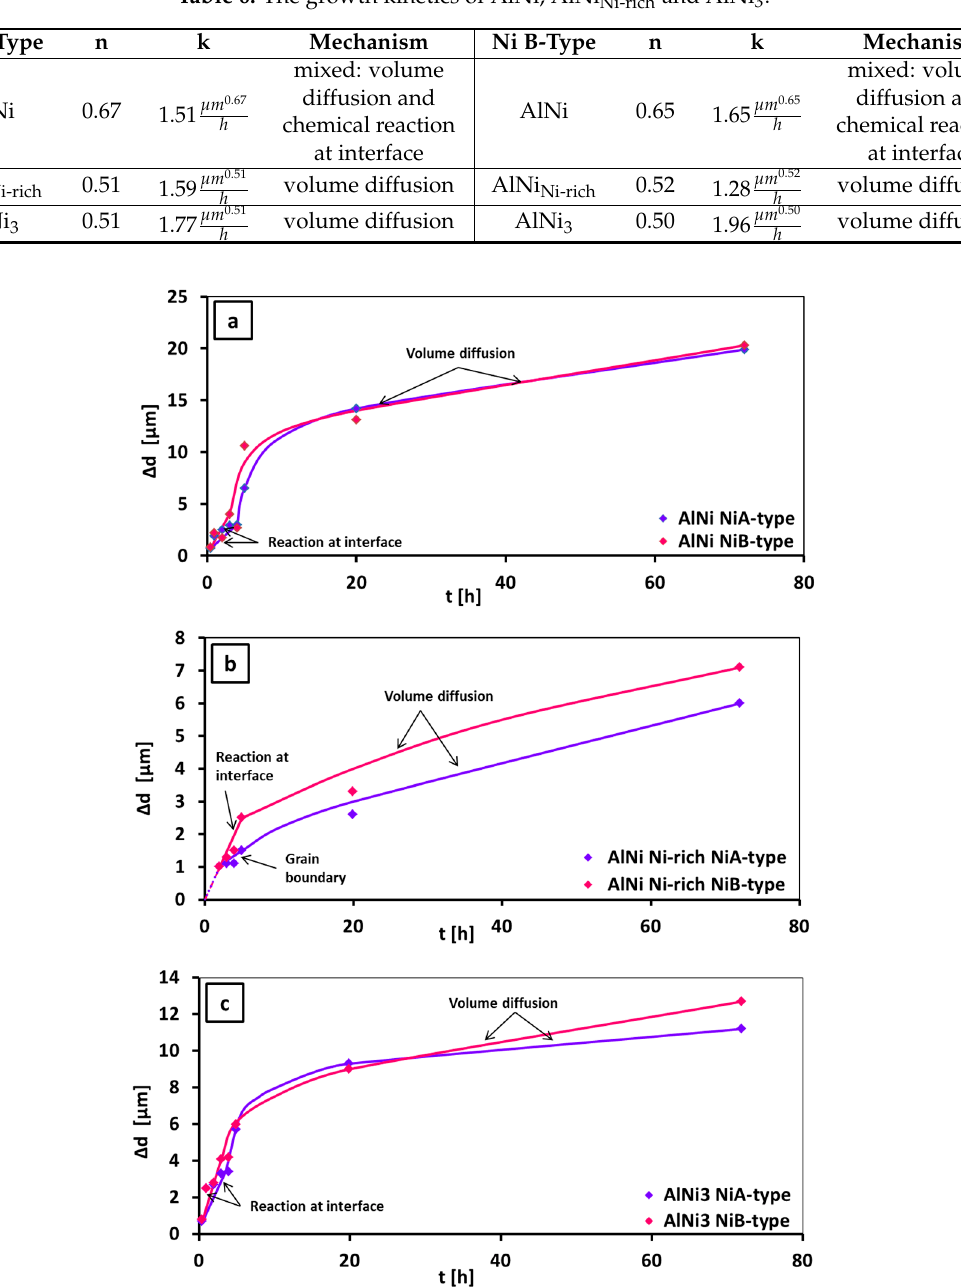
Figure 12. Time dependence of the layer width for stoichiometric AlNi ( a ), AlNi Ni-rich ( b ) and AlNi 3 ( c ) in Ni/Al/Ni joints.